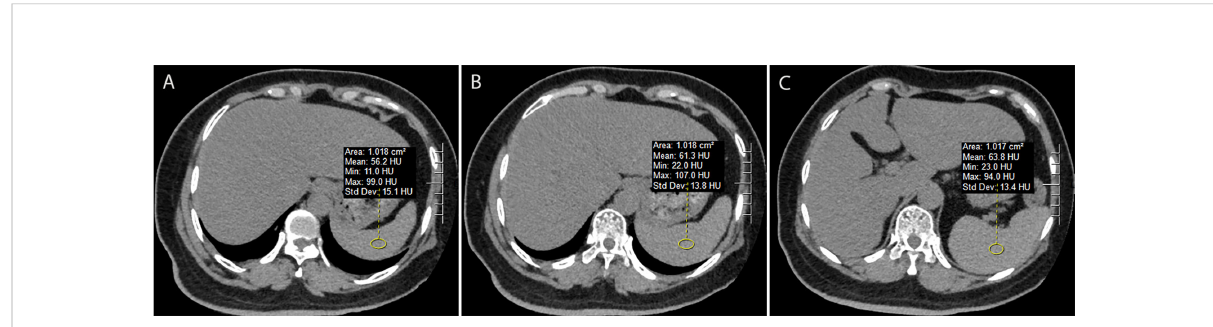
FIGURE 2 Measurement of splenic attenuation (SA) on unenhanced chest computed tomography using imaging Picture Archiving and Communication System. Three circular region-of-interests (about 1.0 cm 2 in size) were placed in the upper (A) , middle (B) , and lower third (C) of the spleen respectively. The average of these three measurements was used for the SA